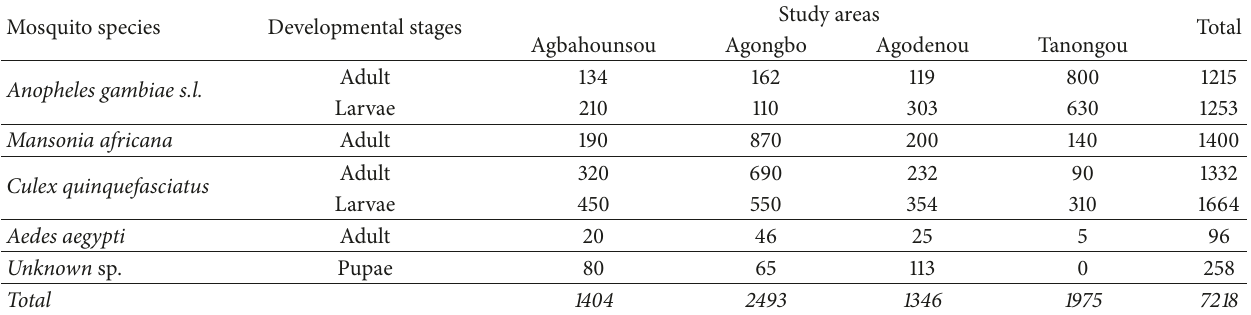
Table 1: Distribution of field-caught mosquito species in study